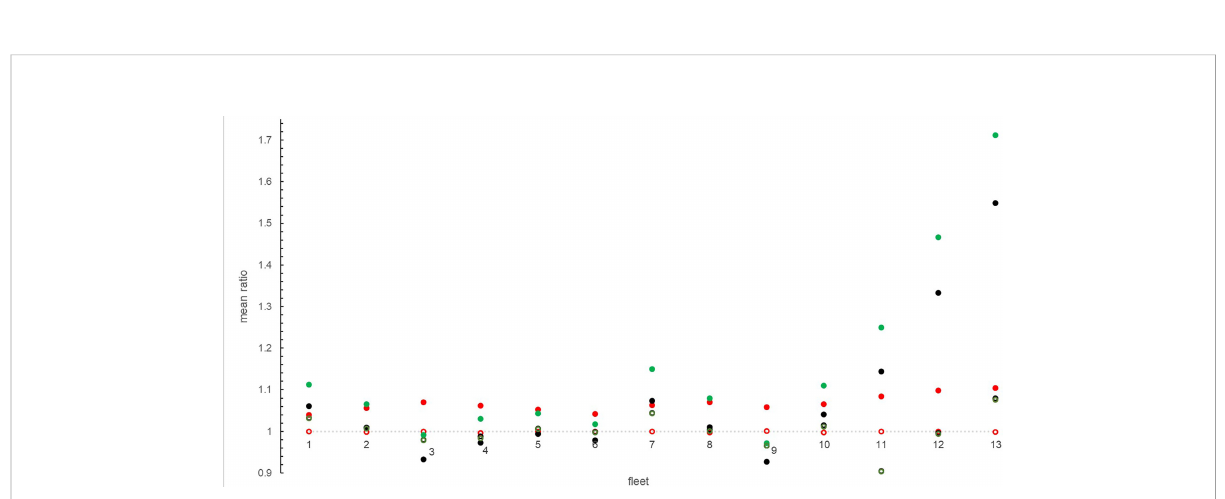
FIGURE 6 Mean ratio of fl eet landings calculated between the alternative scenarios (F, C, FC) and the reference (REF) in the years 2026-2030 (open circle) and 2046-2050 (solid circle). F = black, C = red, FC =